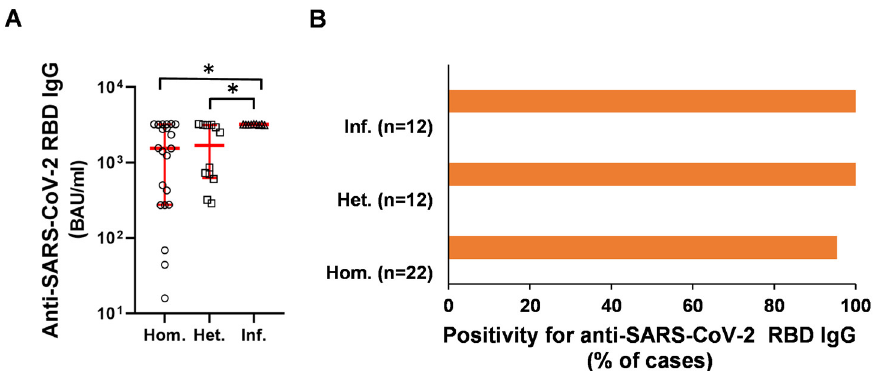
Figure 1. Neutralizing anti-SARS-CoV-2 RBD IgG antibody levels in the three patient groups. ( A ) Subjects receiving homologous (circles: Hom., n = 22), or heterologous (squares: Het., n = 12) booster vaccination or subjects infected after 2 doses of vaccines (triangles: Inf., n = 12) were assayed as described in the 4.4 Materials and Methods section. Horizontal lines—median, whiskers—inter- quartile range (Q1–Q3). ( A ) * p < 0.05 Hom. vs. Inf.; * p < 0.05 Het. vs. Inf. ( B ) The percentage of responders was 95.5% for Hom. and 100–100% for Het. and Inf. groups.